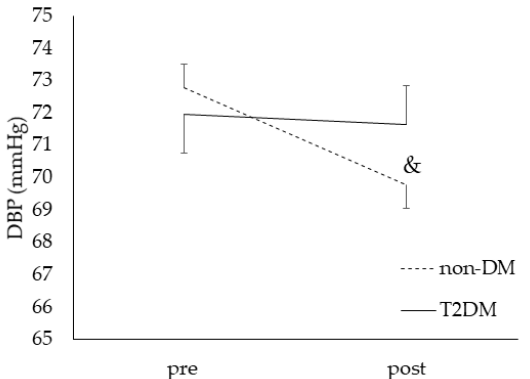
Figure 3. Diastolic blood pressure (DBP) in response to breakfast and capsules ingestion (cocoa flavanols and placebo combined in both groups). Legend: data are means ± SE. Main effects from mixed models when significant: time × group interaction, p = 0.01; post hoc analysis: no significant pairwise group differences, but a significant pairwise time difference in the non-diabetic group ( p < 0.001; &).